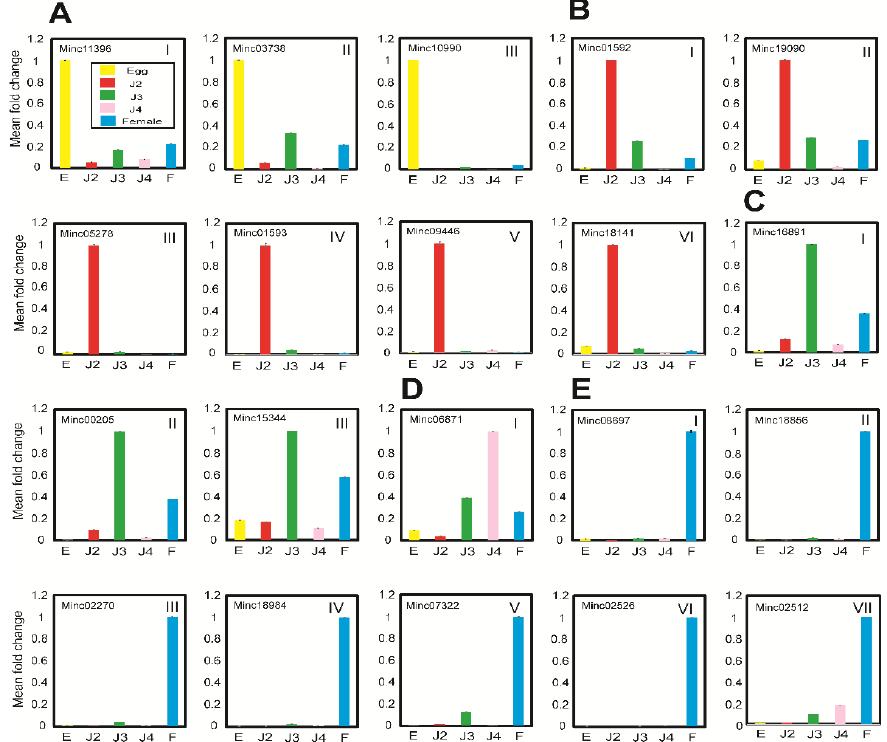
Figure 8. Real-time expression of stage-specific highly expressed mRNAs. ( A ) egg stage; ( B ) J2 stage; ( C ) J3 stage; ( D ) J4 stage; ( E ) female stage. Bar color indicates developmental stage: yellow, egg stage; red, J2 stage; green, J3 stage; pink, J4 stage; and blue, female stage. E: Egg; F: Female.